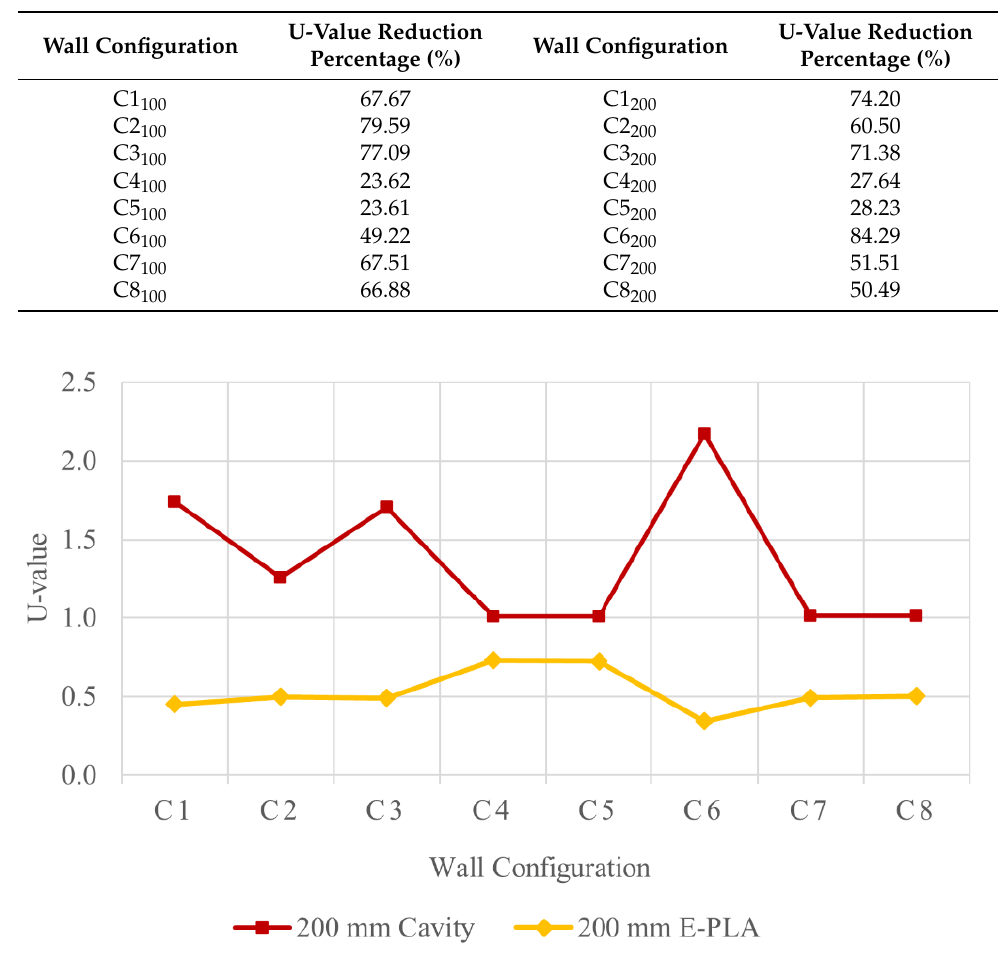
Figure 8. The U-value results obtained for 200 mm wall configurations with and without cavity insulation.